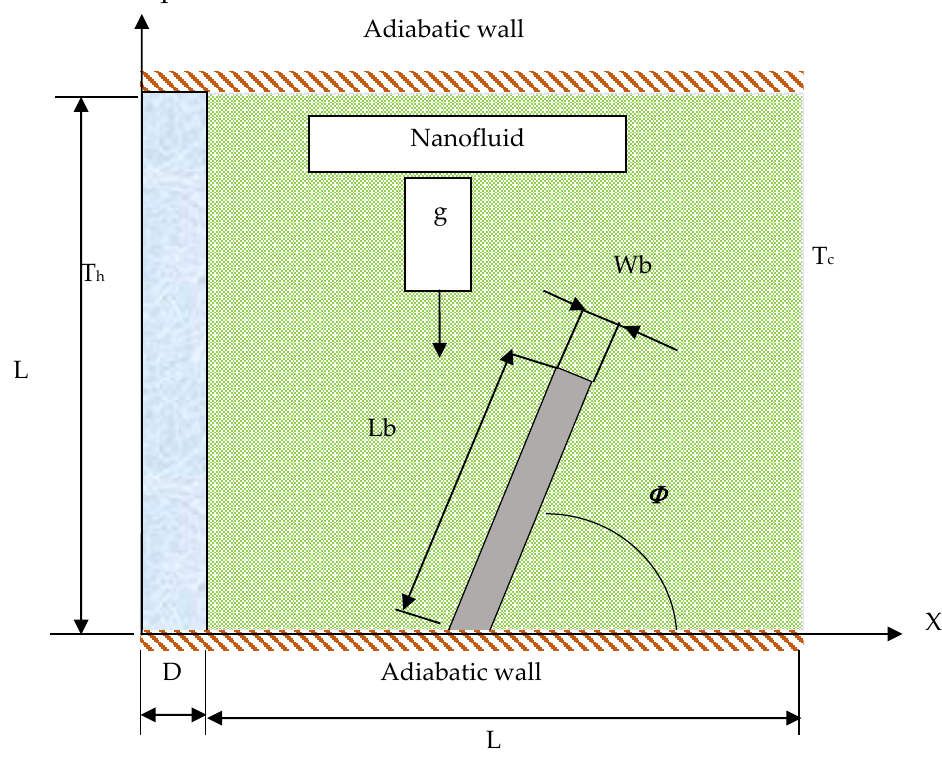
Figure 1. Physical Geometry of the Model. Table 1. Thermophysical properties of fluid and Nanoparticles at T = 25 °C [22].